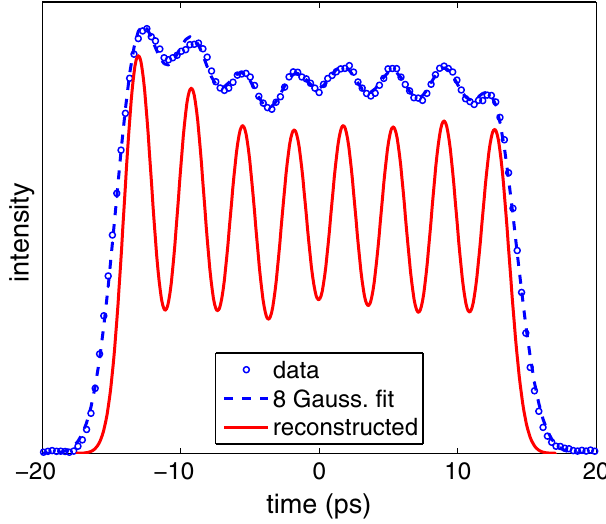
FIG. 7. (Color) The temporal profile of the electron bunches as measured by the deflecting cavity and negligible charge per bunch. The red solid line shows the reconstructed profile used in the simulations. Refer to the text for